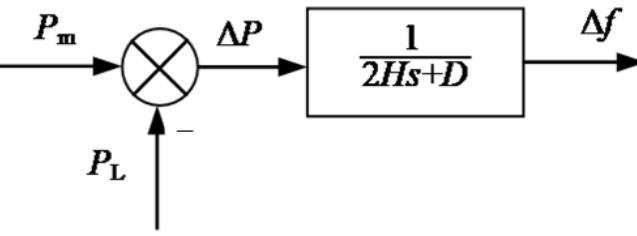
Figure 6. Power-frequency model of the power system.